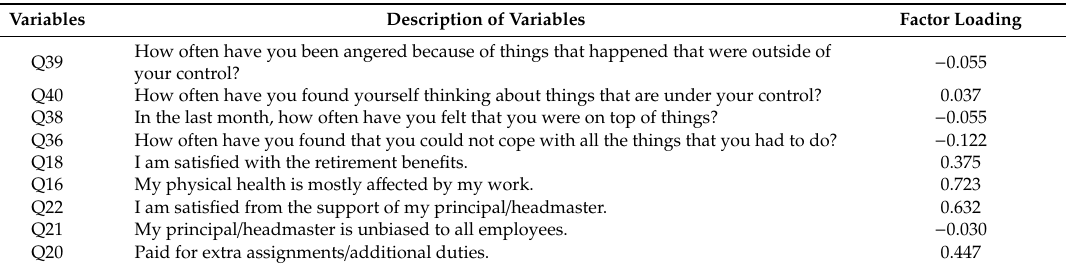
Table 5. Standardized direct e ff ects of INTERNAL.